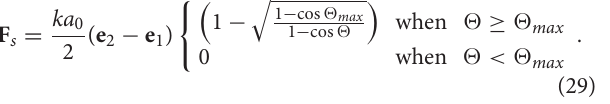
FIGURE 6 | (A) A simulated time sequence of the fountain evolution shown at times t = 1.8, 2.0, 2.5, and 3.5 s. The beads are all of equal size and properties, the larger beads are only drawn in order to track the beads which are colored blue when they are outside the horizontal extent of the container and given a brass color when they are not. (B) Simulated and experimental fountain.